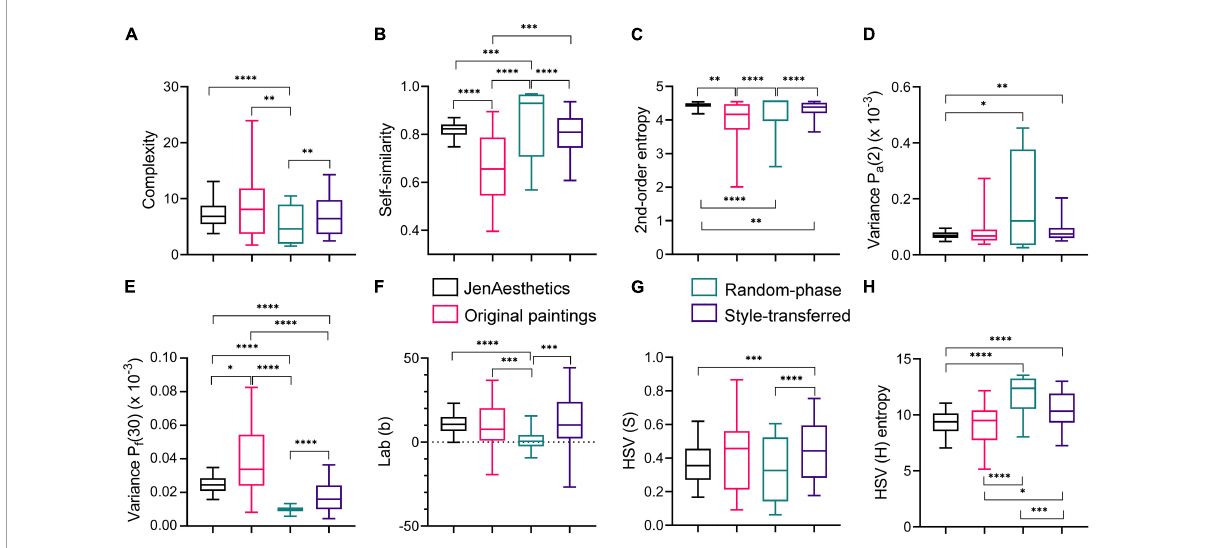
FIGURE4 Statistical image properties (SIPs) of the four image categories. The panels (A–H) show box plots of the values of all eight SIPs, respectively, as indicated on the y-axis of the plots. In each plot, data are shown for the JenAesthetics dataset of 1629 traditional Western paintings ( black ), the 25 original abstract paintings ( red ), the 150 random-phase images ( green ), and the 150 style-transferred images ( purple ). The boxes encompass the median ( horizontal line ) and represent the 25 – 75 percentiles. The whiskers indicate the 5 – 95 percentiles. Significance levels for the differences between the pairs of image categories are indicated at the top or at the bottom of the panels. Multiplicity-adjusted significance levels are ∗ p < 0.05; ∗∗ p < 0.01; ∗∗∗ p < 0.001; ∗∗∗∗ p <